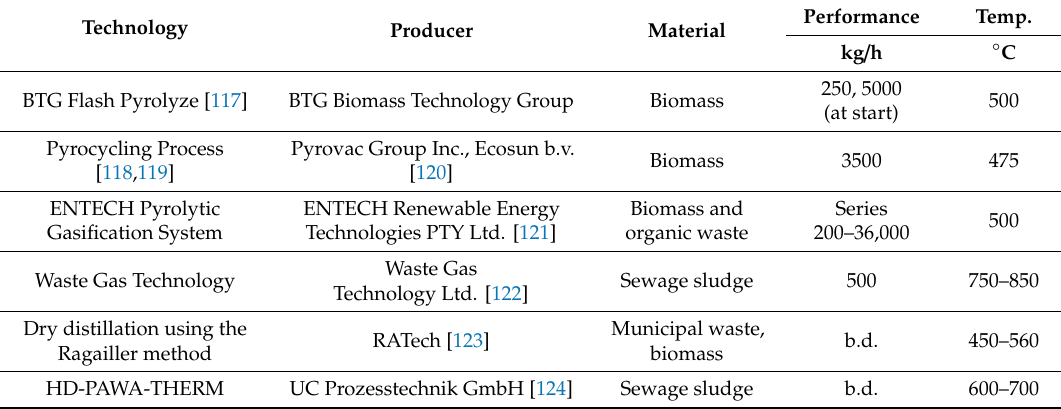
Table 4. The most popular and the latest biomass pyrolysis technologies [17].